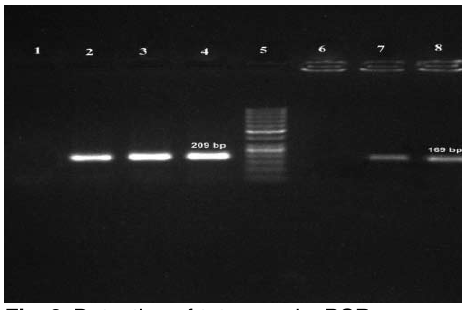
Fig. 2. Detection of tet genes by